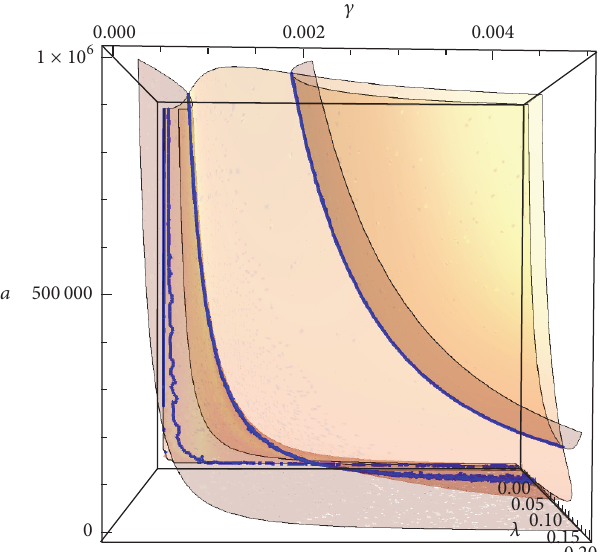
Figure 4: This is a magnified view of the plot in Figure 2 to show the view along 𝜆 -axis more